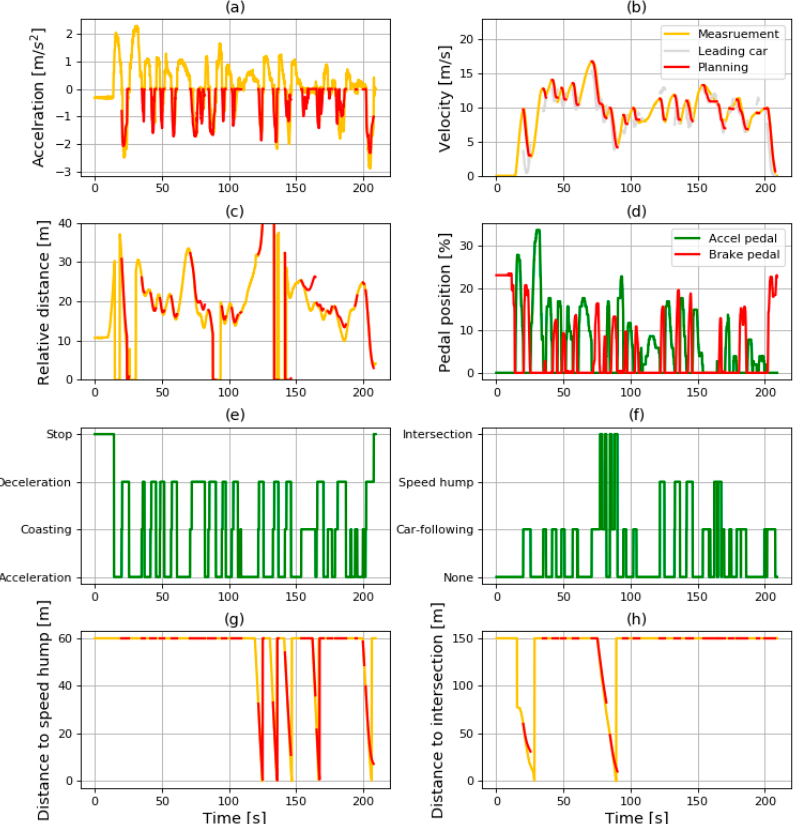
Figure 15. Result of ( a ) acceleration; ( b ) velocity; ( c ) relative distance; ( d ) pedal position; ( e ) driving state; ( f ) deceleration condition; ( g ) distance to speed hump; ( h ) and distance to intersection in driving simulation.